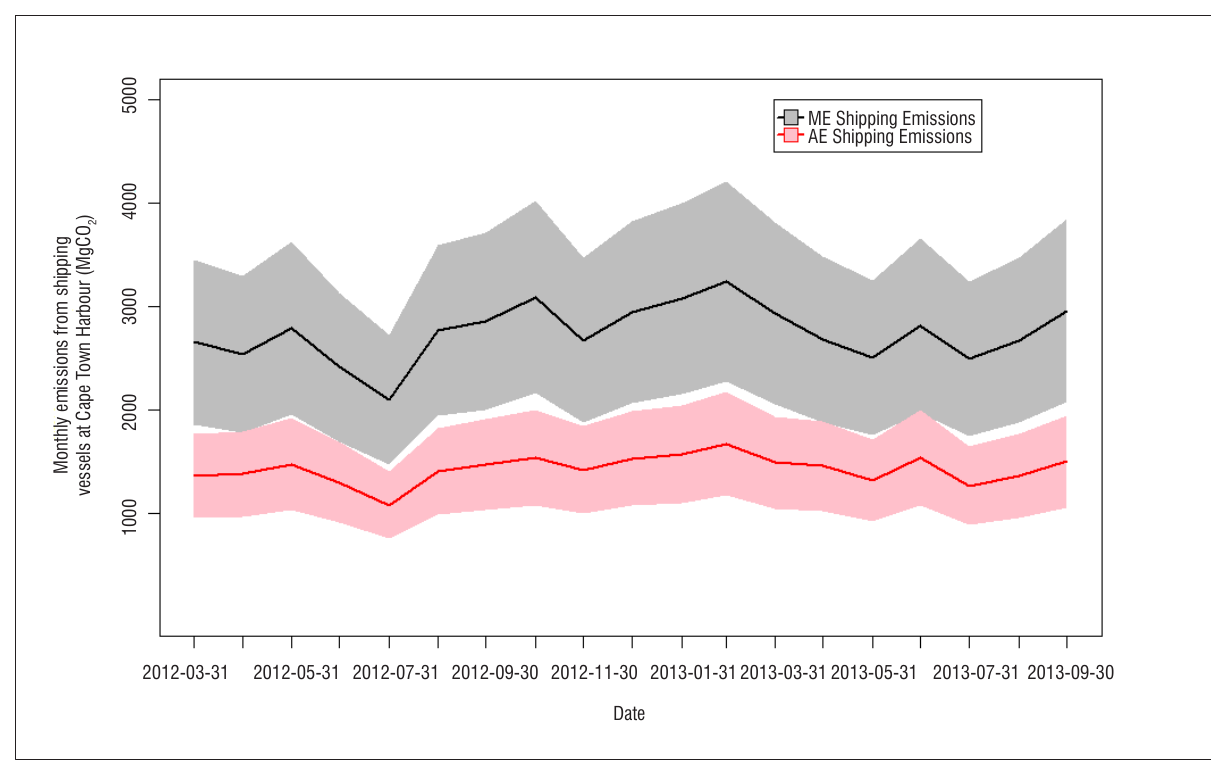
Figure 8: Monthly emissions from shipping vessels at Cape Town harbour. The shaded region represents the region of uncertainty in the emission